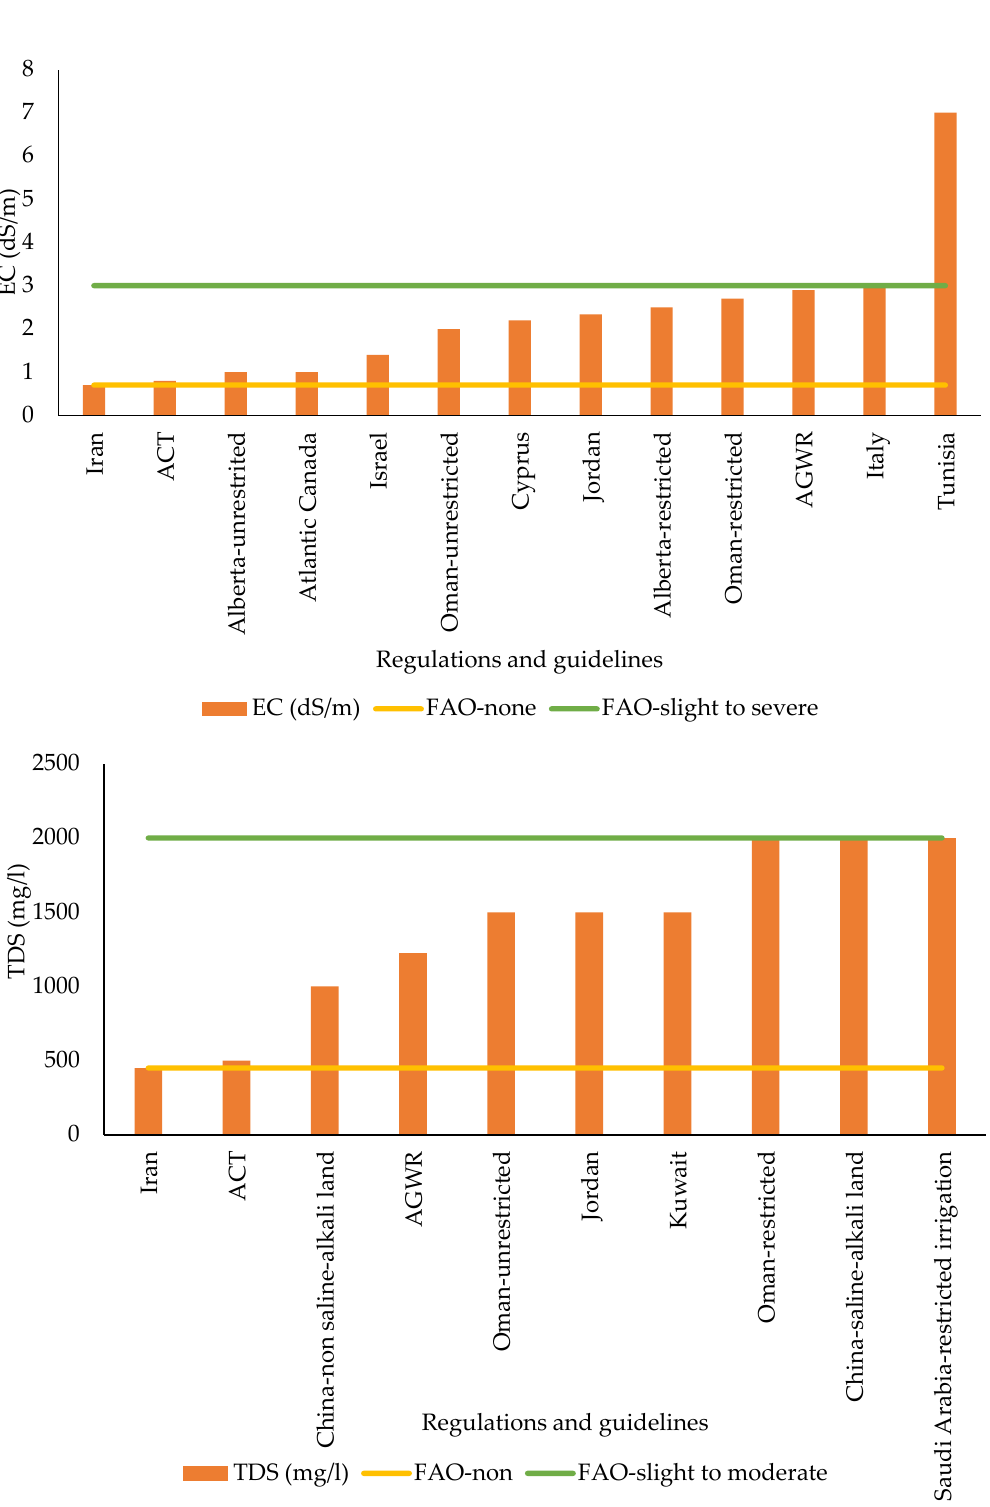
Figure 3. Salinity (electric conductivity (EC) and total dissolved solids (TDS)) thresholds in agricultural water reuse regulations and guidelines.